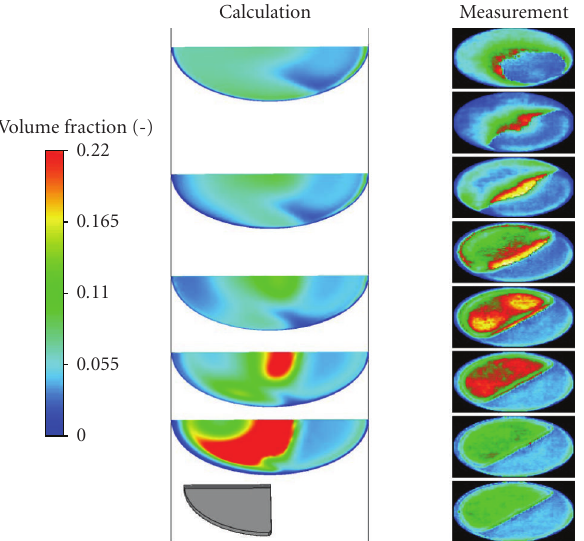
Figure 16: Calculated by CFX (left) and measured (right) gas cross- fractional distributions downstream the obstacle (run 097 J L = 1 . 611 m/s, J G = 0 . 0898 m/s, F B = F C = 0 . 05). Calculations (obstacle shown), distances at z = 0 . 08 m, 0.16 m, 0.25 m, 0.37 m, and 0.52m. Measurements (obstacle in the upper left area). distances at z = 0 . 01m, 0.015 m, 0.02m, 0.04m, 0.08 m, 0.16 m, 0.25 m, and 0.52m.